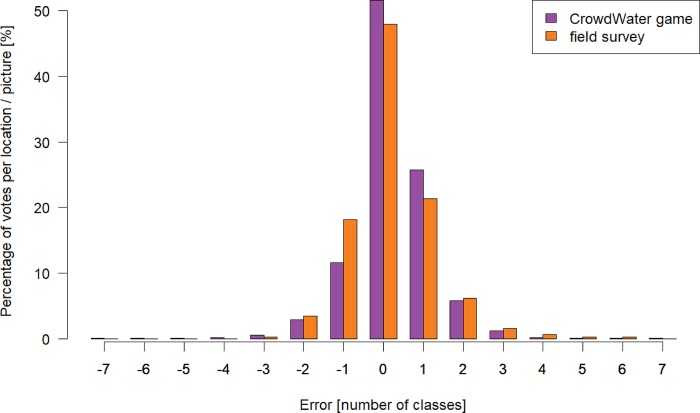
Error distribution of the water level classes for the CrowdWater game and a field survey.Comparison of the error distribution of the votes in the CrowdWater game (difference between the vote of a player and the mean game vote for that observation; n = 841) and for previously held field surveys (n = 517) [data from 49].